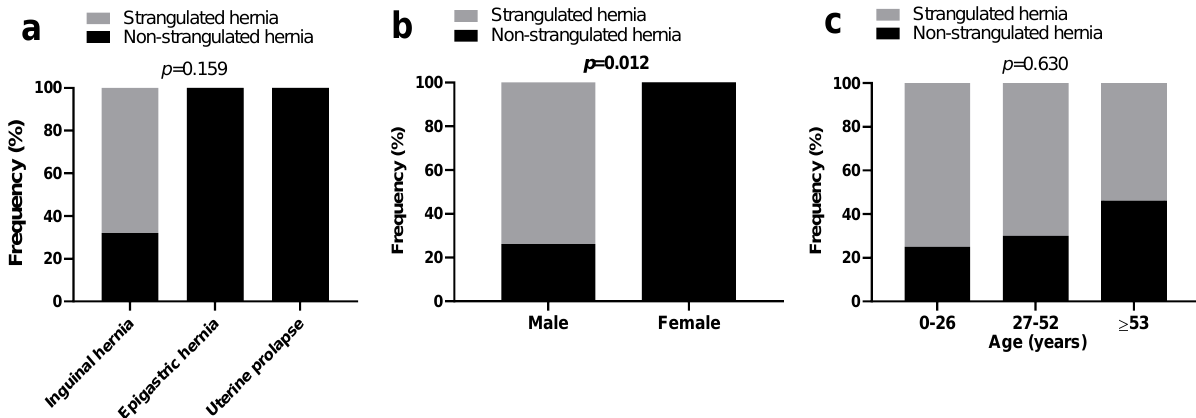
Figure 3. Frequency of hernia-associated clinical complications (strangulated and non-strangulated) stratified by [a] diagnosis, [b] gender, and [c] age group of the study subjects at Mankranso District Hospital, Ghana. Pearson Chi-Square and Fisher’s exact tests were used appropriately to compare difference in proportions of clinical characteristics between gender and age groups; p≤0.05 was considered